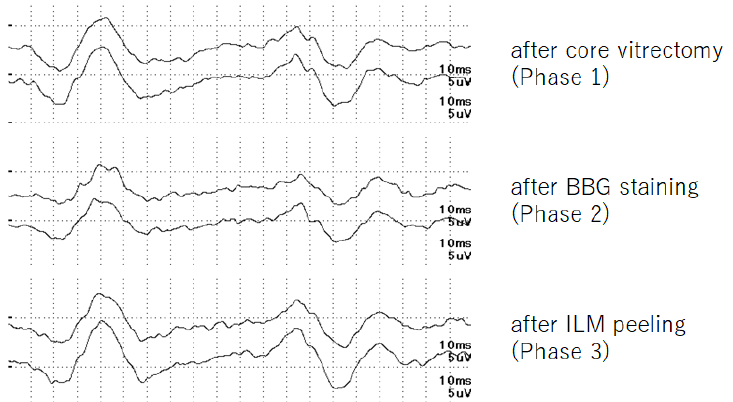
Figure 1. Representative iFMERG graph.